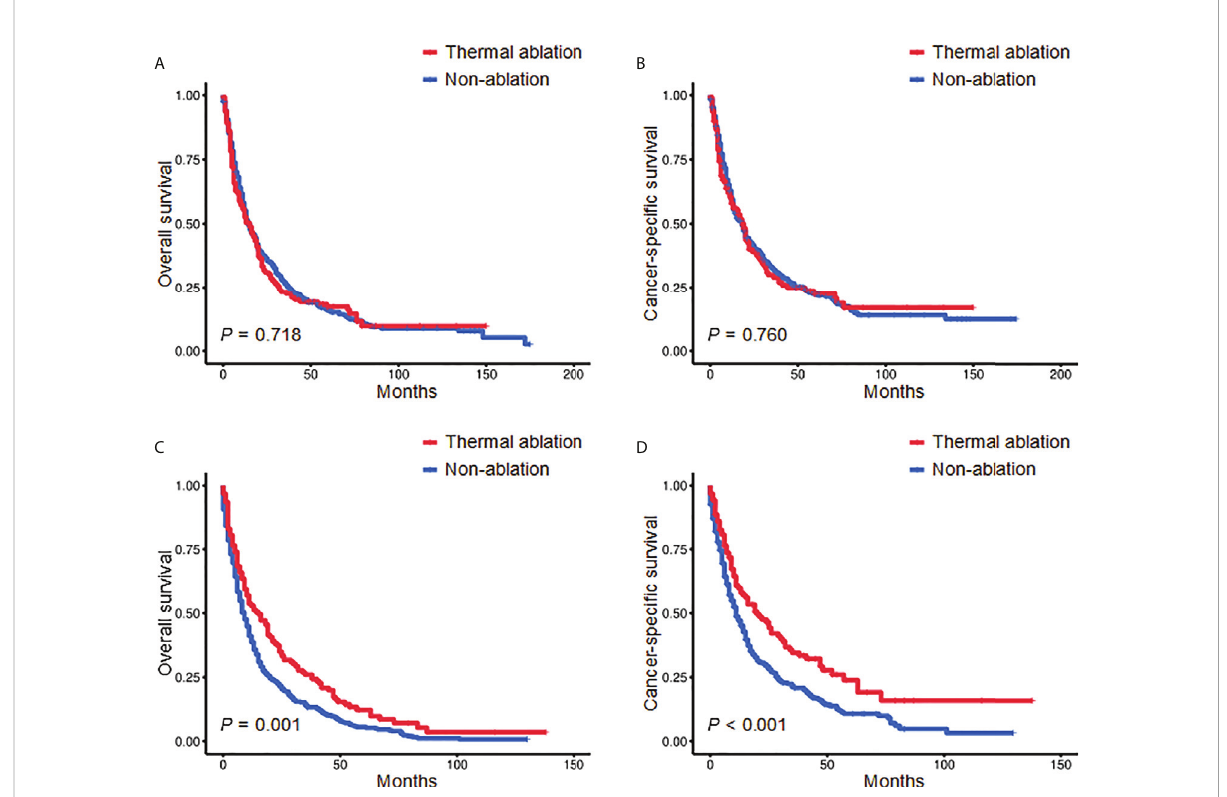
FIGURE 2 Kaplan-Meier survival curves comparing the TA and non-ablation groups when age was <70 years (A, B) or ≥ 70 years (C, D) after PSM. TA, thermal ablation; PSM, propensity score